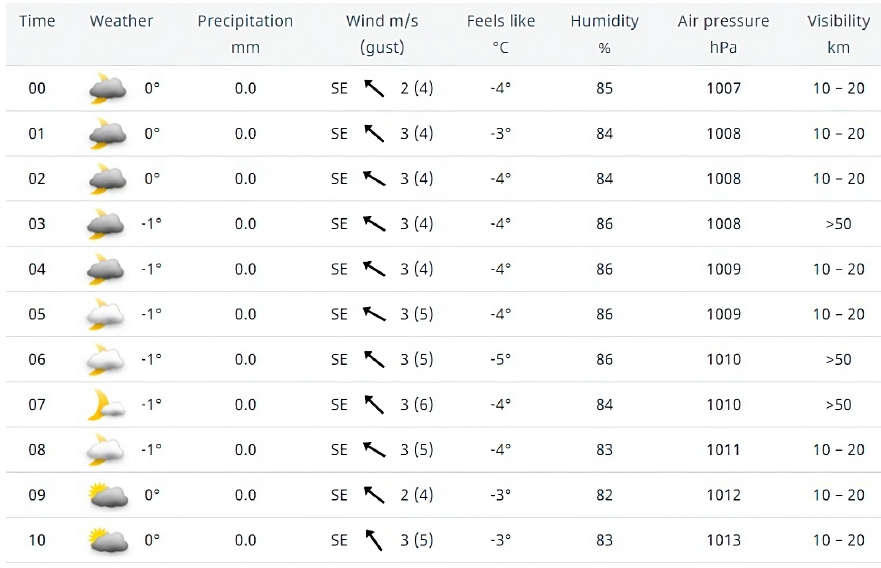
Figure 2. An example of weather forecast by SMHI (from SMHI website).